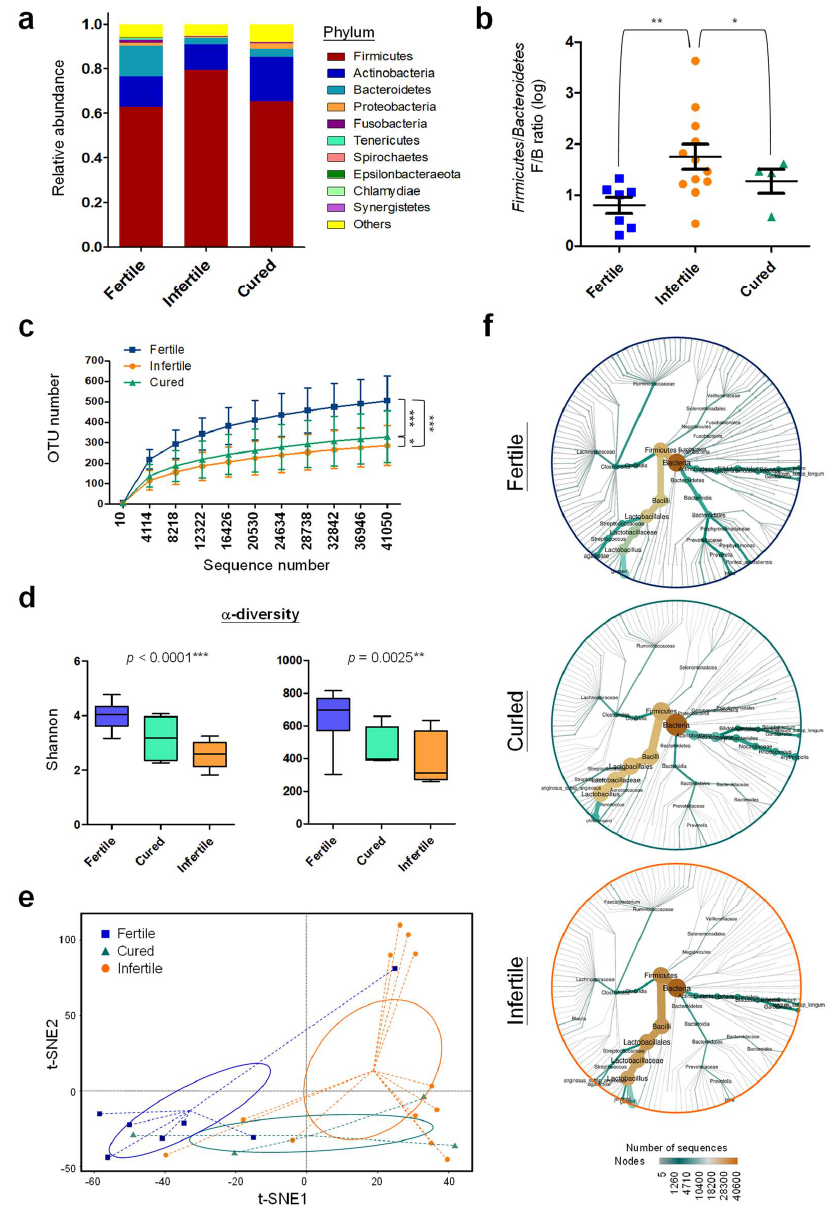
Figure 6. Abundance and composition of cervical microbiomes in endometriosis patients with different reproductive ability. ( a ) Relative abundance of the top-10 major phyla of cervical microbiomes in patients with different reproductive ability are shown in distribution histogram. ( b ) Firmicutes/Bacteroidetes (F/B) ratios in cervical microbiomes of patients between two groups are compared by t-test. ( c ) The rarefaction curves indicate the differences in biodiversity (accumulated OTU numbers) of patients with different reproductive ability. Statistics were performed with two-way ANOVA method. ( d ) One-way ANOVA indicates the trend of alterations in alpha-diversity according to the reproductive ability of patients by using Shannon ( left ) and Chao1 ( right ) methods. ( e ) The t-SNE analysis diagram was plotted to calculate the actual and embedded distance among different patient groups. ( f ) Phylogenetic heat trees were constructed to reveal the abundance and diversity of microbiotas in different patient groups. Statistical significance: *, p < 0.05; **, p < 0.01; ***, p <